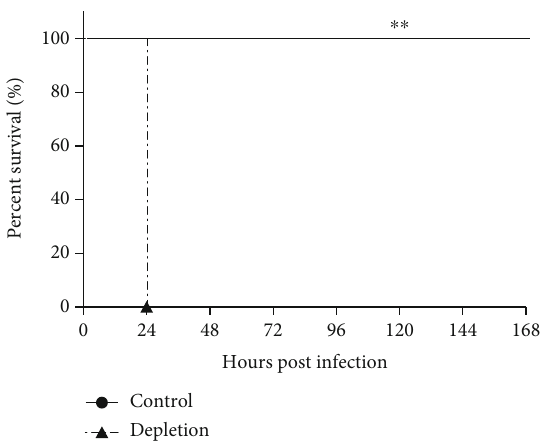
Figure 7: Innate immune e ff ectors exhibited synergy e ff ect in K. pneumoniae lung infection. Three pathways were simultaneously disrupted, and mice ( n = 5 ) were intratracheally administrated with 5 × 10 5 CFUs of strain YBQ 48h later. The mice were monitored for 7 days to calculate the survival rate. Statistical analyses were analyzed using the log-rank test. P < 0 : 01 ( ∗∗ ) compared to control